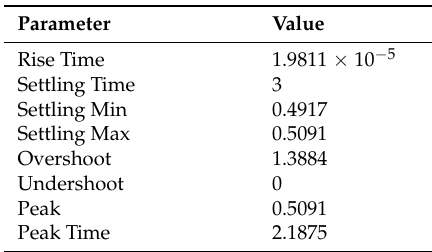
Table 4. Characteristics of the motor flux curve.